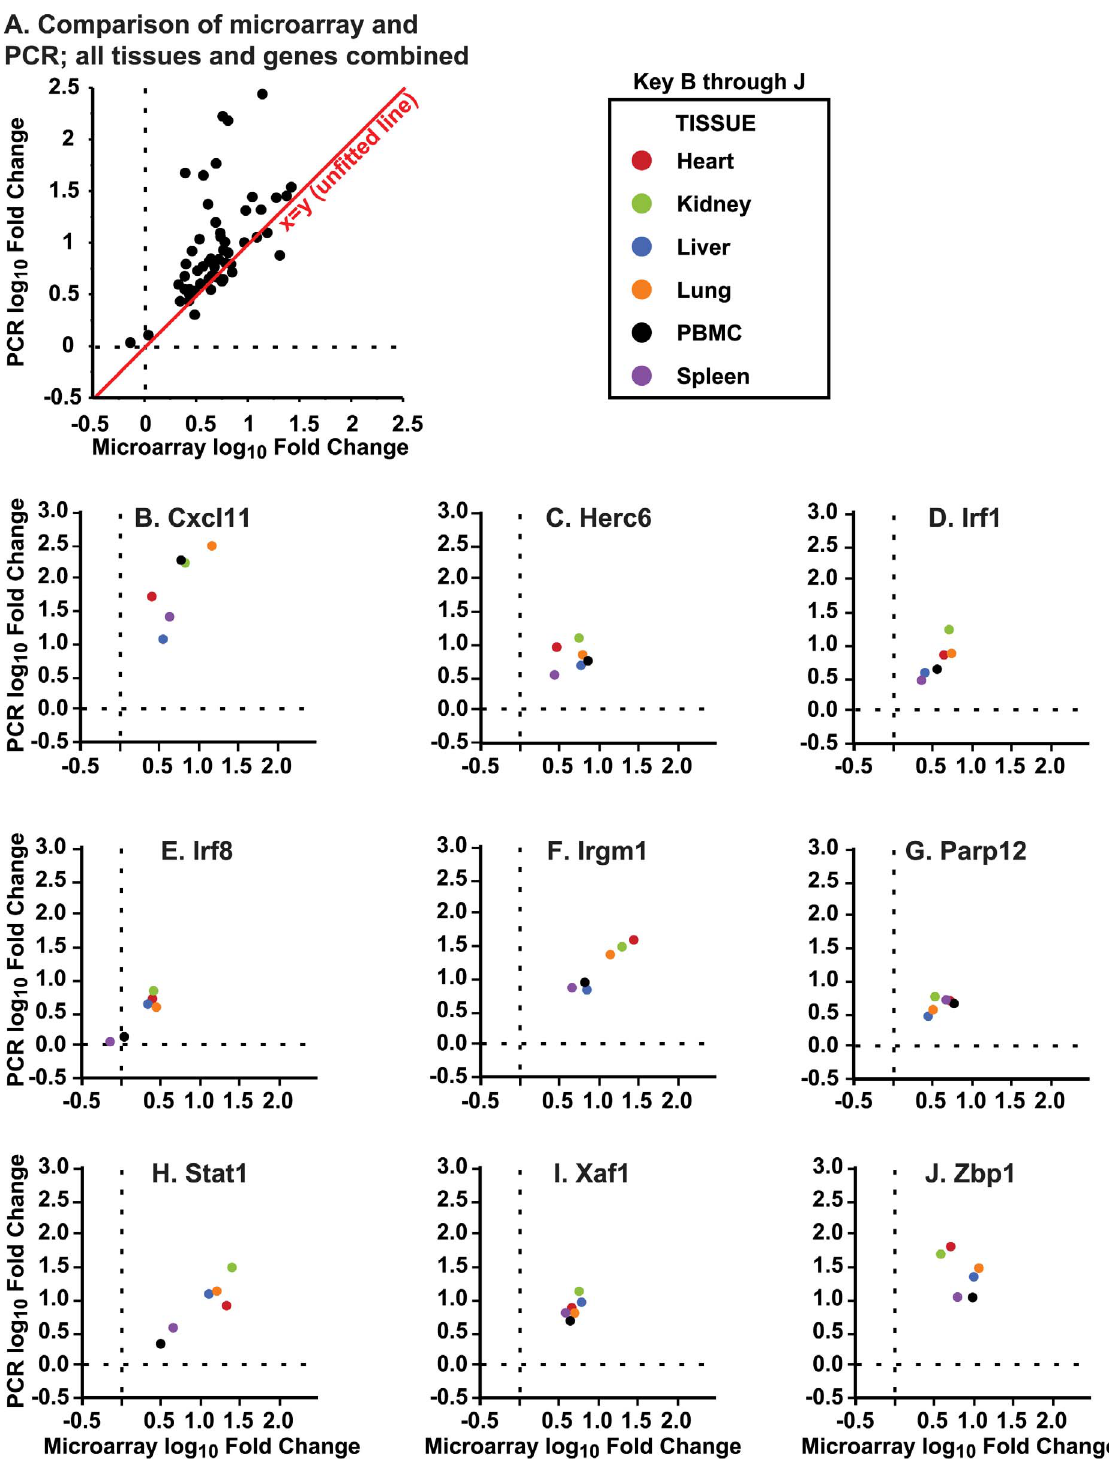
Figure 4. Quantitative real-time PCR (qRT-PCR) confirmation of tissue-wide changes in gene expression. Nine genes were quantitated by qRT-PCR across all 6 tissues at 24 h. (A) Scatter plot of all genes and tissues tested comparing microarray and qRT-PCR fold-change from control. As shown by the line of identify (x = y), qRT-PCR typically returned higher fold-change results than microarray. Gene specific results, colored by tissue (see Legend), are shown as follows: (B) Cxcl11; (C) Herc6; (D) Irf1; (E) Irf8; (F) Irgm1; (G) Parp12; (H) Stat1; (I) Xaf1; and (J) Zbp1. All qRT-PCR results met the . 1.5 fold-change cut-off for gene selection, except for measurements of Irf8 in PBMCs and spleen. However, Irf8 similarly failed selection by microarray in these tissues at 24 h. Four samples were tested per tissue. Each PBMC sample represented a pool of multiple mice while each organ sample came from an individual mouse.